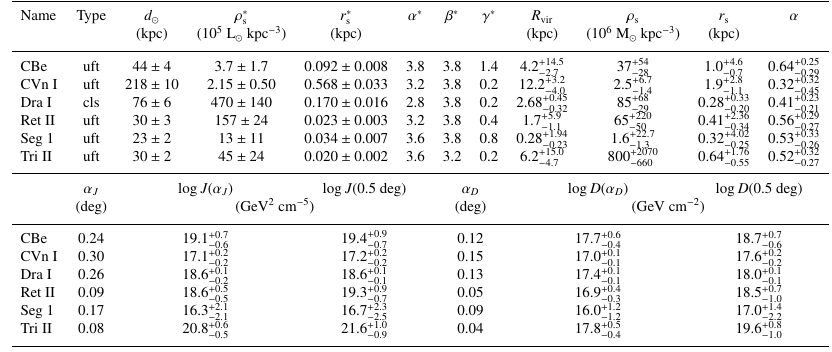
Table 1: Top: best-fit parameters – heliocentric distance d (cid:12) [21]; 3D brightness scale density ρ ∗ dSph virial radius R vir ; 3D DM density scale ρ s , radius r s and index α [16] – for the six analyzed dSphs, classified for type (‘cls’: classical, ‘uft’: ultra-faint). Bottom: logarithmic astrophysical factors log J and log D for DM self-interaction, computed at their optimal angles ( α J = 2 r ∗ s / d (cid:12) or α D = r ∗ s / d (cid:12) respectively) and at 0 . 5 deg for a direct comparison with the literature [16, 22, 23].